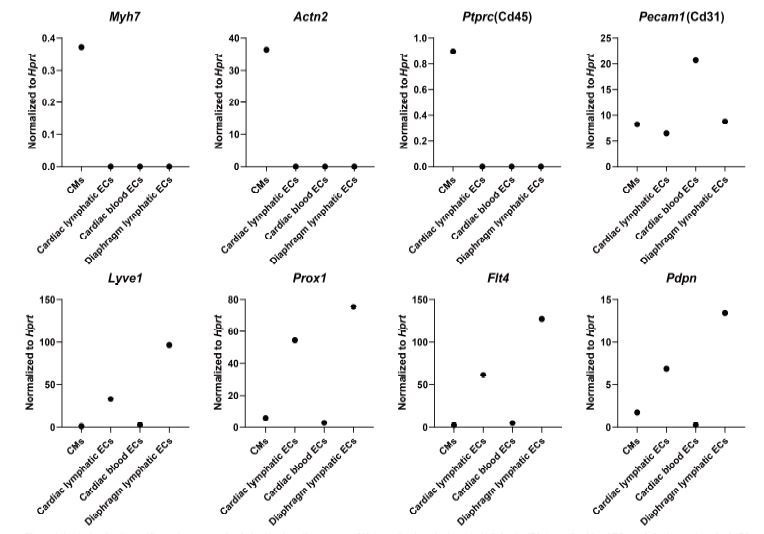
Analysis of cell-specific marker expression in isolated cardiomyocytes (CMs), cardiac lymphatic endothelial cells (ECs), cardiac blood ECs and diaphragm lymphatic ECs.The cells were isolated from the heart and diaphragm of a Prox1-eGFP mouse following the cell isolation procedure shown in Figure 4—figure supplement 1D in main manuscript. RNA was isolated from the cells, and quantitative RT-PCR was performed for Myh7, Actn2, Ptprc, Pecam1, Lyve1, Prox1, Flt4, Pdpn and normalized to the expression of housekeeping gene Hprt(n=1/group).